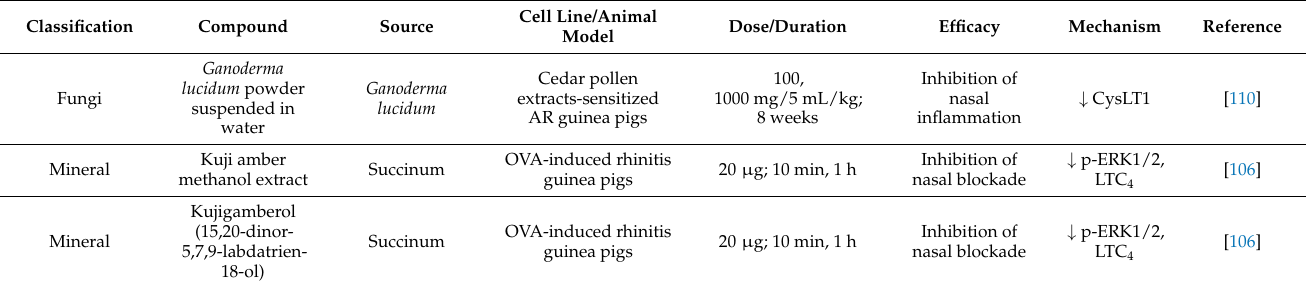
Table 4. In vivo studies—Fungi and